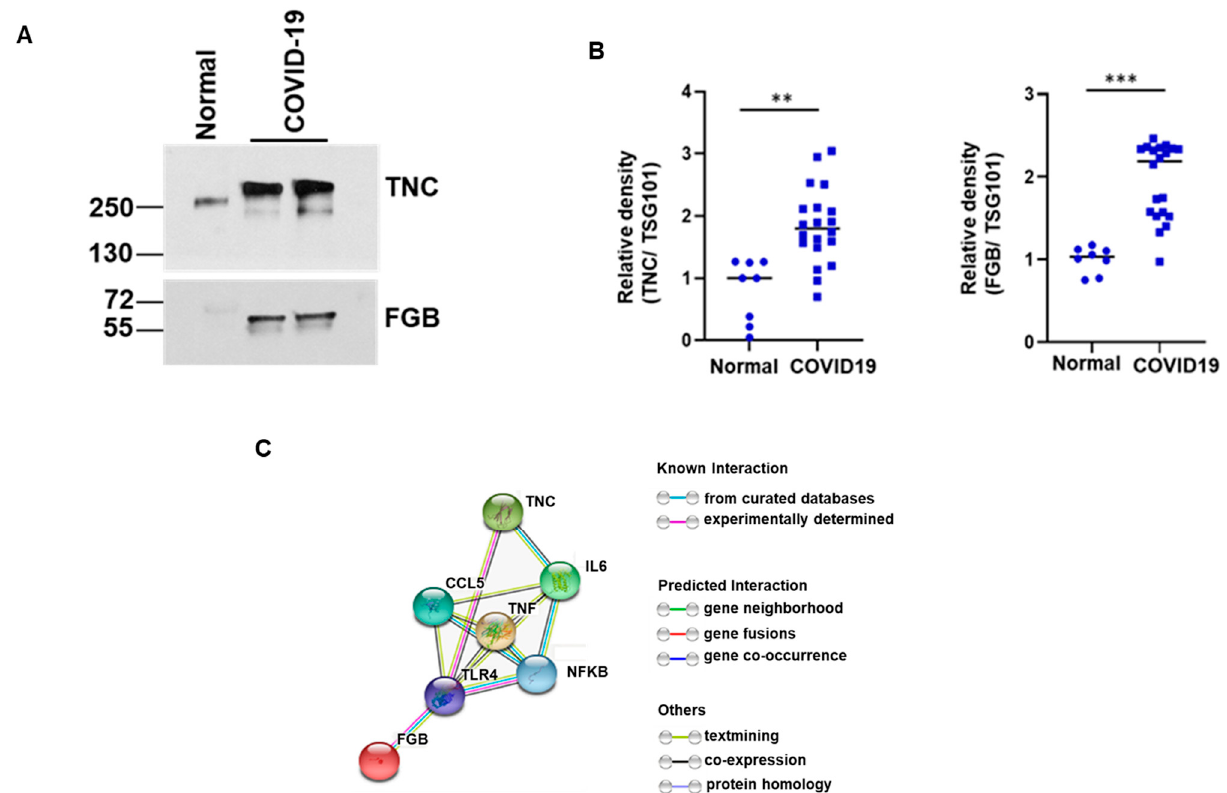
Figure 3. Tenascin-C (TNC) and fibrinogen- β (FGB) are highly present in exosomes of COVID-19 patients. ( A ) Lysates from COVID-19 plasma exosomes and normal exosomes were subjected to Western blot analysis for TNC and FGB using specific antibodies and a representative image is shown. ( B ) Dot plots for quantitative Western blot band intensities by densitometry analysis using ImageJ software are shown ( n = 8 normal and n = 20 COVID-19 samples). TSG101, an exosomal marker protein, was used for normalization of each sample. (** p < 0.01; *** p < 0.001). ( C ) String analysis network module represents functional association of TNC and FGB with TLR4/NF- κ B signaling. Each node represents all the proteins produced by a single protein coding gene. Colored node represents query proteins and first shell of interactions. Filled node shows 3D structure (known or predicted). Edges represent protein–protein associations for shared function.